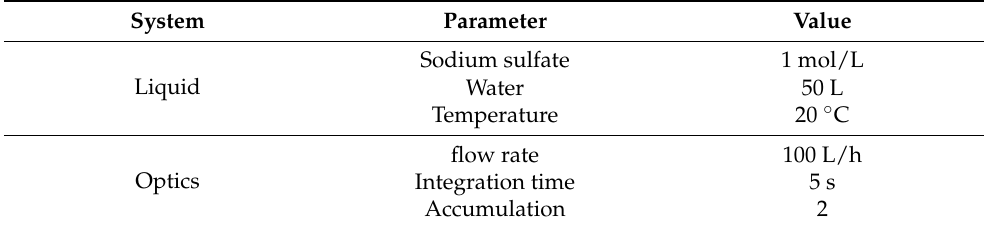
Table 4. Plant and optical